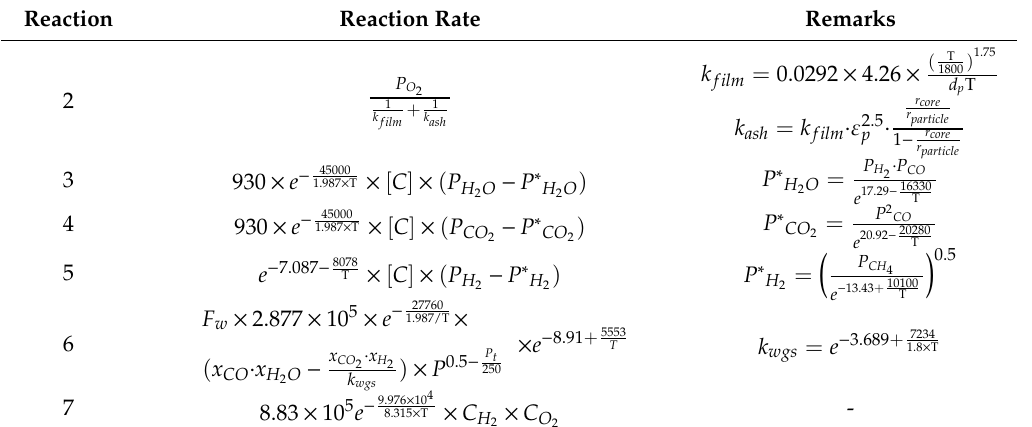
Table 1. Reaction rates for reactions (2)–(7) [28].